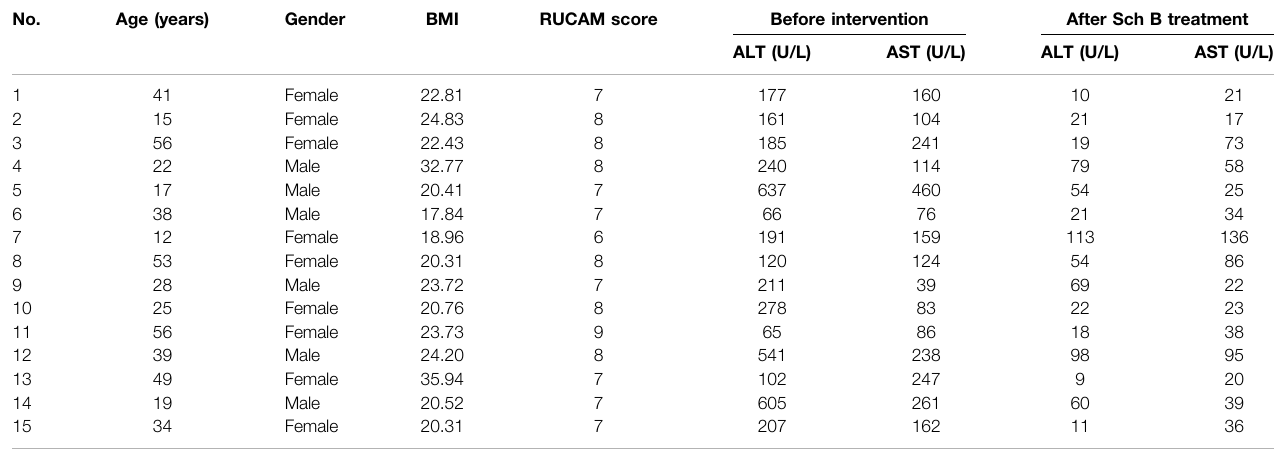
TABLE 3 | The clinical data of DILI patients in this study.